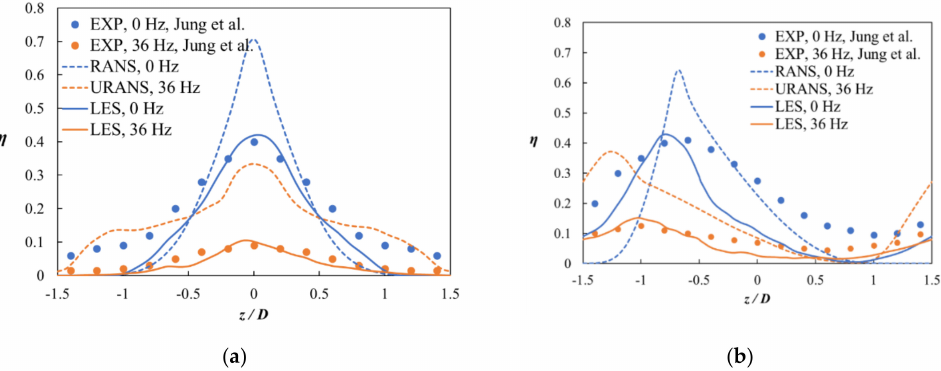
Figure 6. Distribution of the time-averaged η m at x/D = 5. ( a ) Simple angle ( β = 0 ◦ ); ( b ) Compound angle, β = 30 ◦